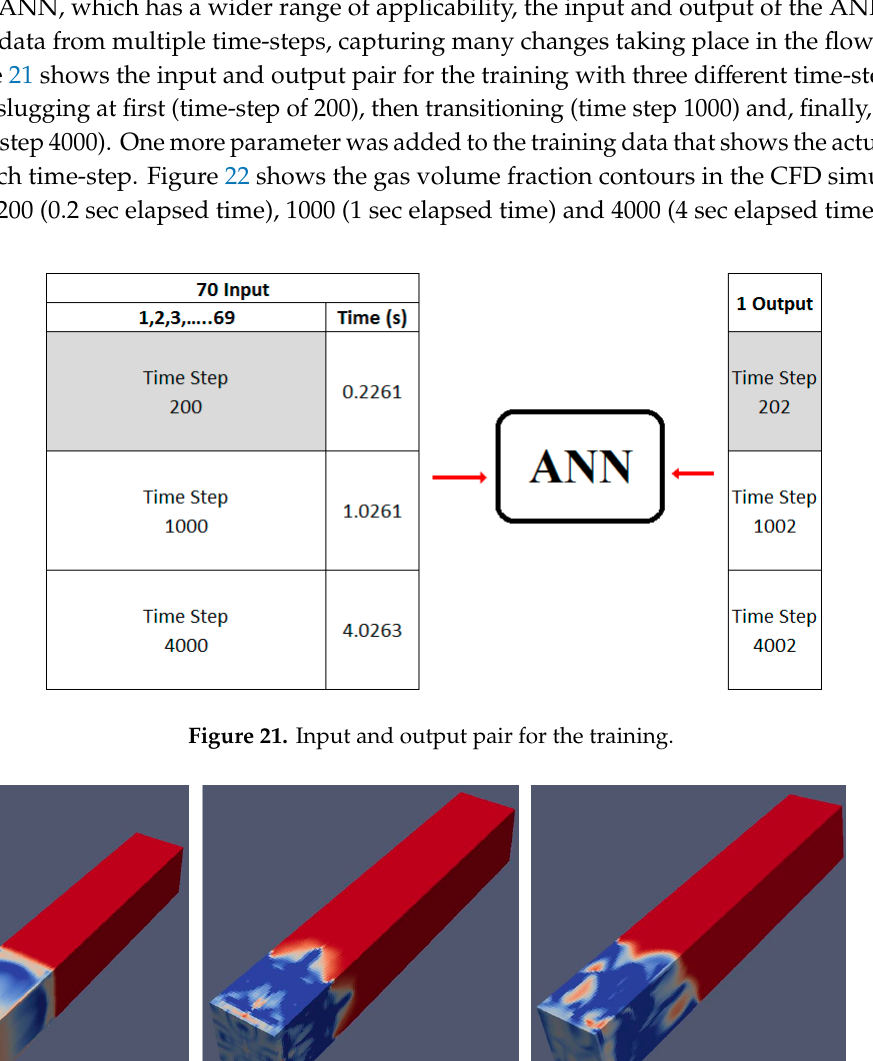
16 of 36 Figure 20. CFD and cascading smart proxy results for gas volume fraction at K = 7 cross-sectional plane and time step = 4020. 3.3. Training with Multiple Time-steps